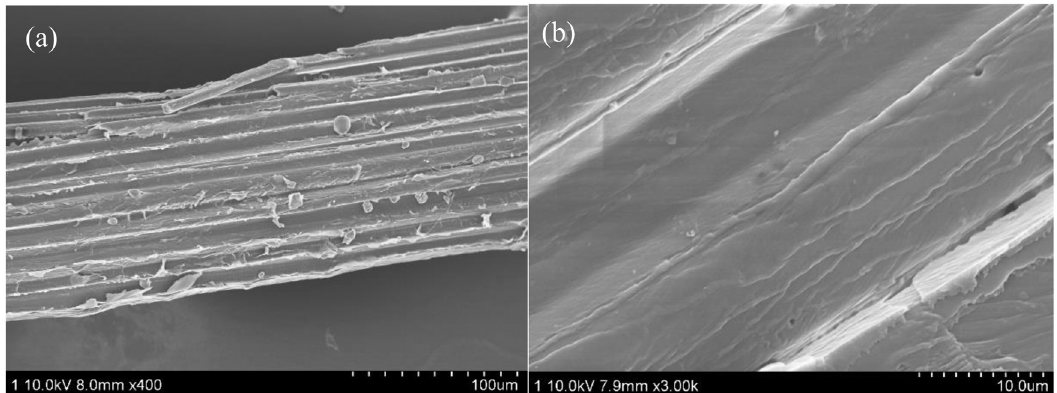
Figure 1: SEM images: ( a ) untreated BP, ( b ) BP after alkali treatment.